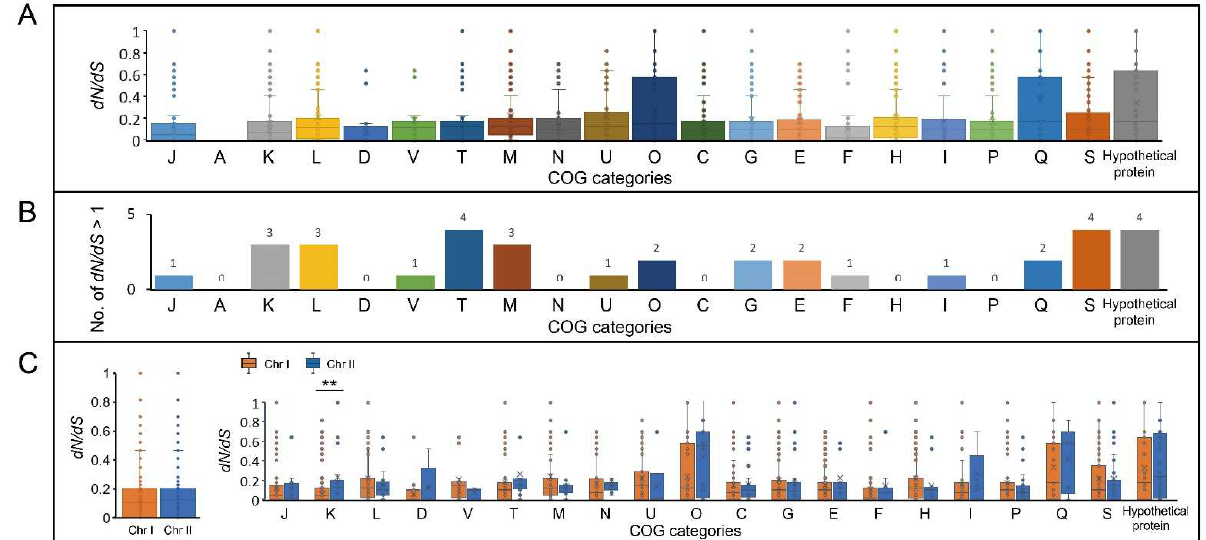
Figure 4. Selective pressure on functional categories in the V. cincinnatiensis core genome. ( A ) Dis- tribution of the nonsynonymous ( dN )/synonymous ( dS ) rates of the core gene families in COG functional categories; ( B ) distribution of COG categories for gene families with positively selected sites; ( C ) comparisons of the dN / dS rates of core gene families between Chr I and Chr II in COG functional categories. ** t -test p -value <